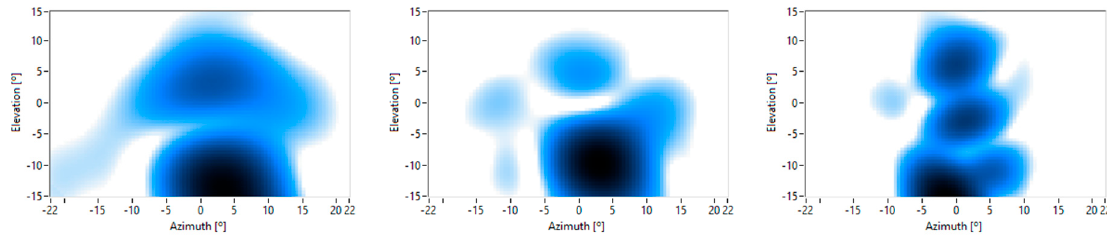
Figure 14. Acoustic images of a person with increasing frequencies, from left to right, at a constant range.